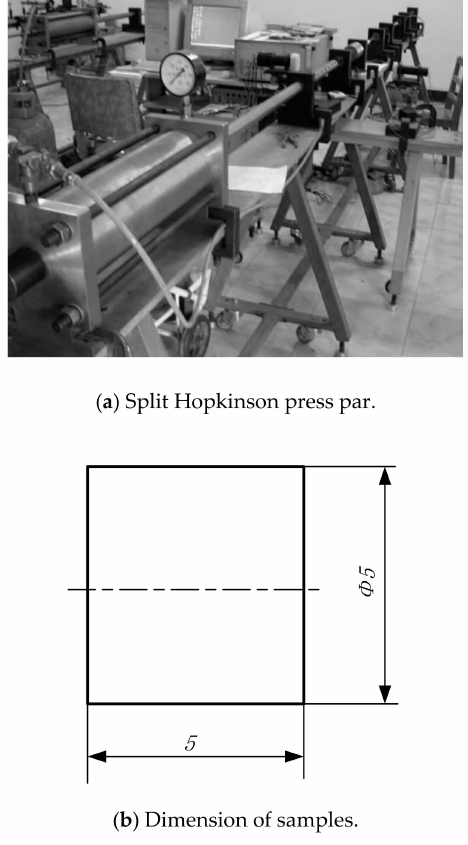
Figure 2. Equipment of the SHPB